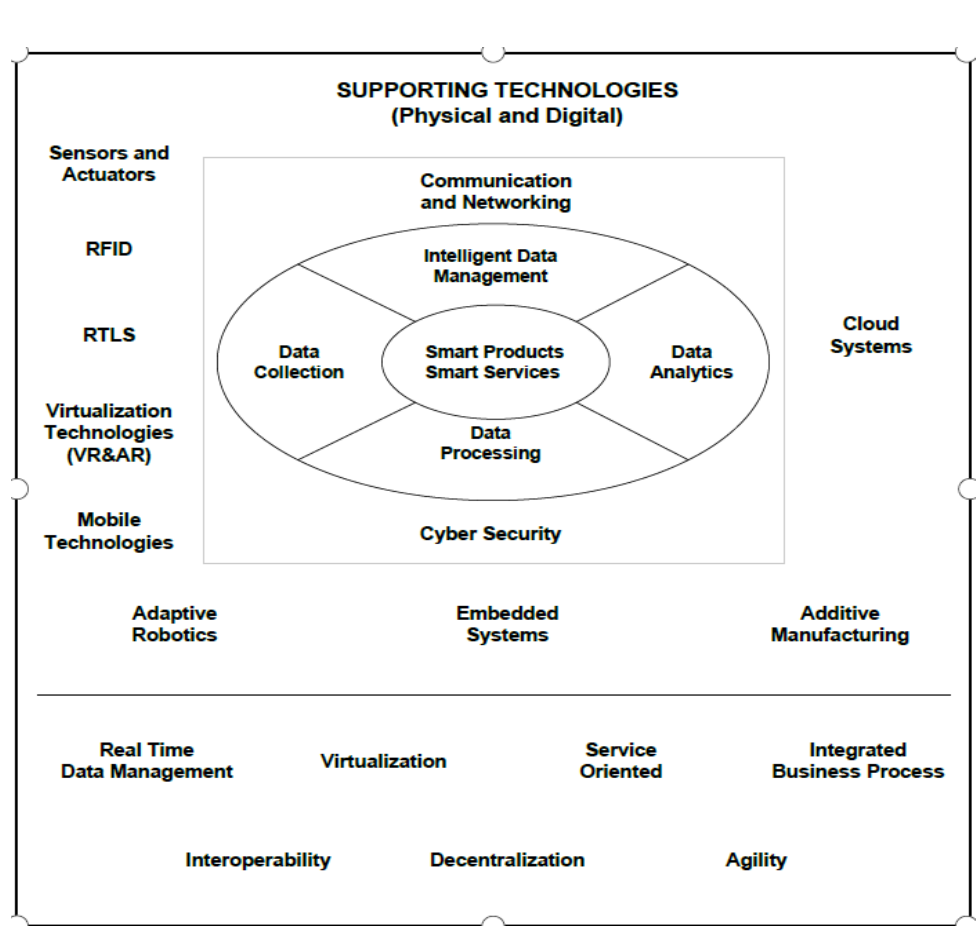
Fig. 1. Industry 4.0 framework transmission (Salkin, Oner, Ustundag & Cevikcan,